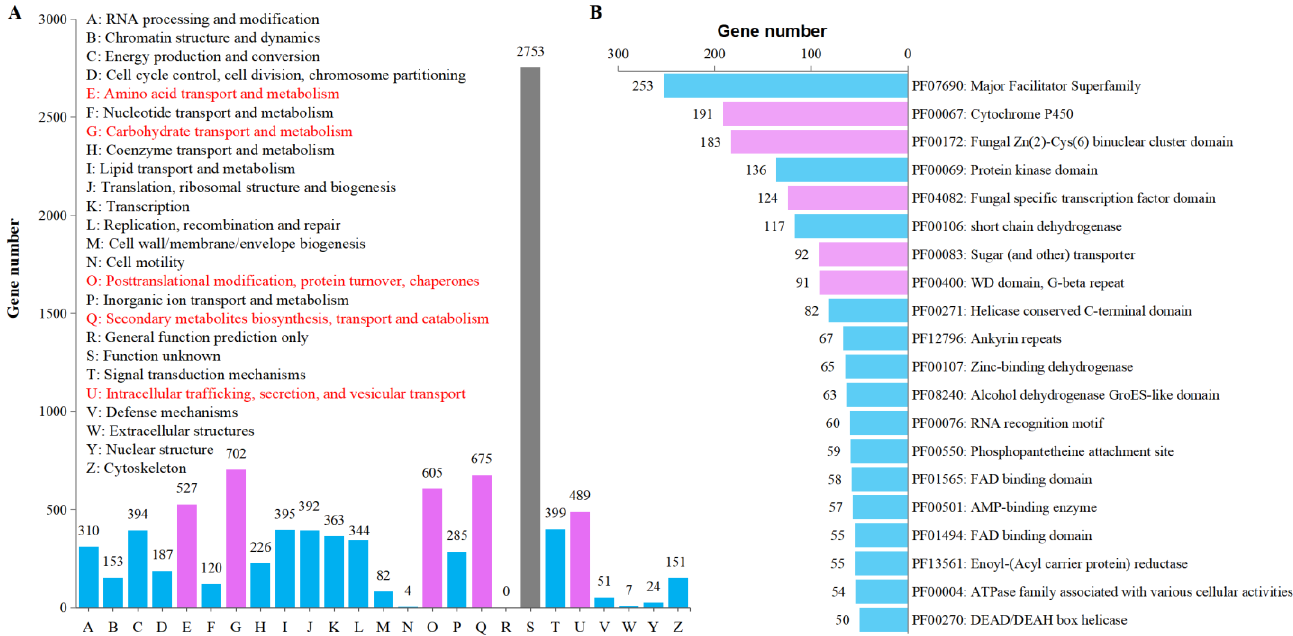
Figure 5. General gene functional annotation. ( A ) KOG annotation and ( B ) Pfam annotation (top20). Red color indicates the top terms associated with candidate pathogenicity-related genes.